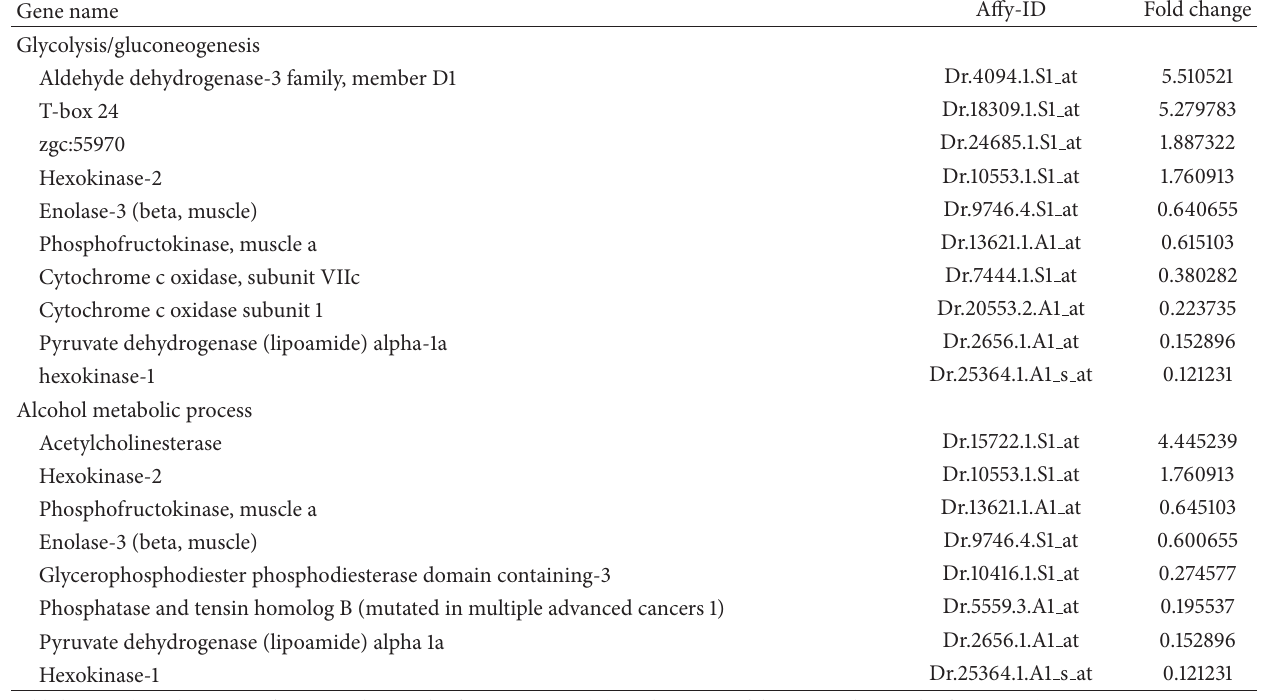
Table 4: Differentially expressed genes involved in carbohydrate metabolism in the muscle of crisp grass carp and grass